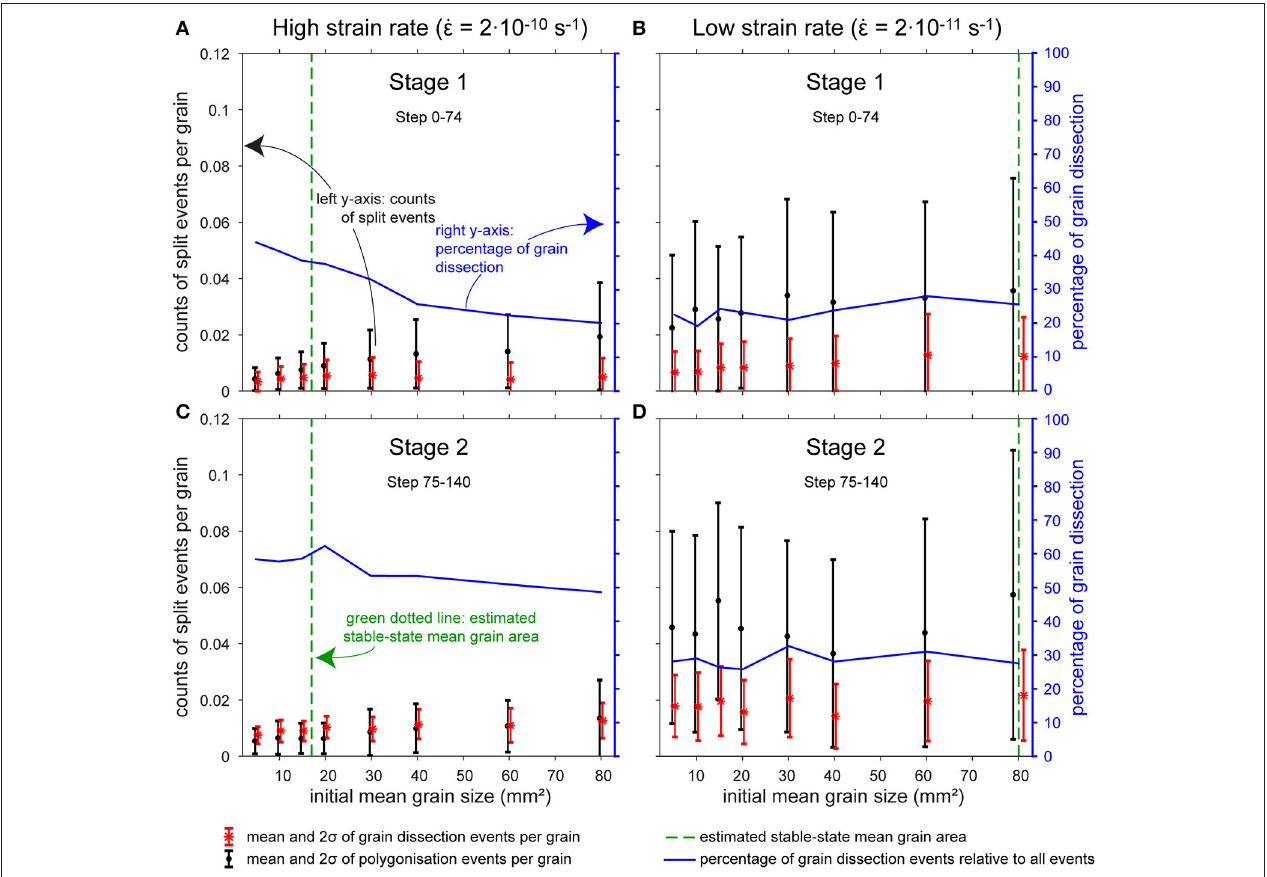
FIGURE 6 | Statistics of grain-dissection and polygonisation events per grain. Data is sorted for the (A,B) first and (B,D) second stage of grain size evolution and (A,C) high and (B,D) low strain rate. The first stage was taken from step 0 to 74 (0–31% shortening) and the second one step from 75 to 140 (from 31% shortening). Error bars indicate two standard deviations (2 σ ) of the counting statistics. The dotted green line indicates approximate stable mean grain areas for the high and low strain-rate simulations. The blue line and right y-axis show the mean percentage of grain-dissection events per grain from the total number of splitting events by grain dissection and